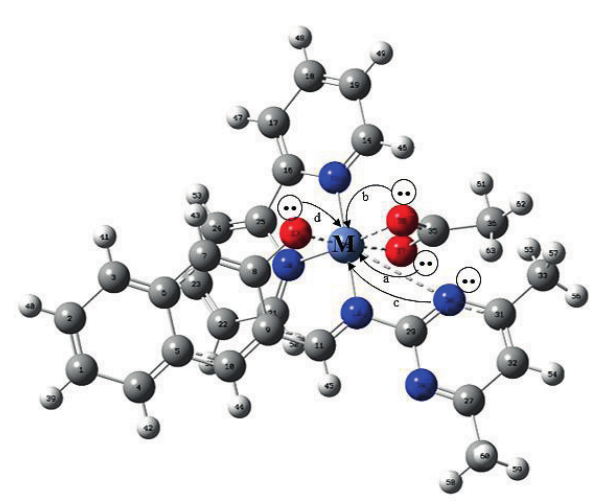
Figure 6: Representation of intermolecular charge transfer for the complexes obtained from the Fock-matrix in NBO analysis. The curved arrows (a, b, c and d) represent the direction of charge transfer from lone pair to antibonding (LP→ LP * and σ*) . M = Co 2+ , Zn 2+ , Ni 2+ , Mn 2+ .